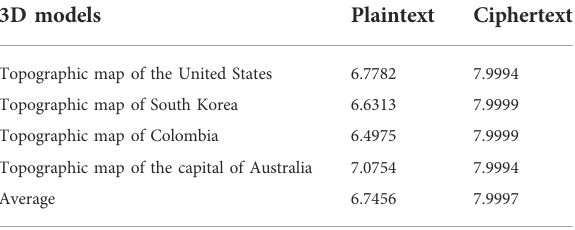
TABLE 2 Information entropy of SMCLM-3ME.